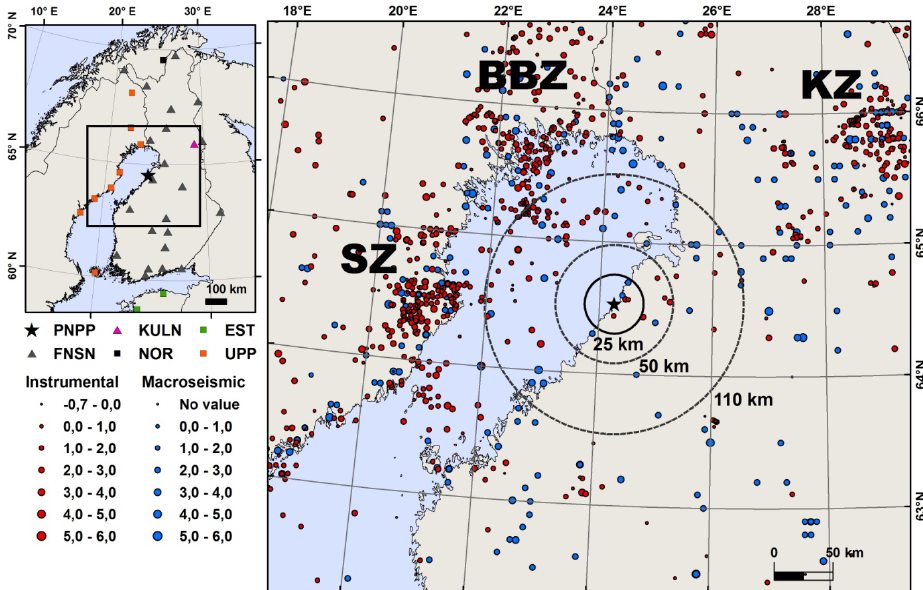
Figure 1. A seismicity map of the Central Fennoscandia for the time period 1375-2010 (Ahjos and Uski, 1992). Macroseismic (–1970) and instrumental (1971-) epicentres are denoted by blue and red dots, respectively. Concentric circles show the survey area. Seismicity zones: SZ